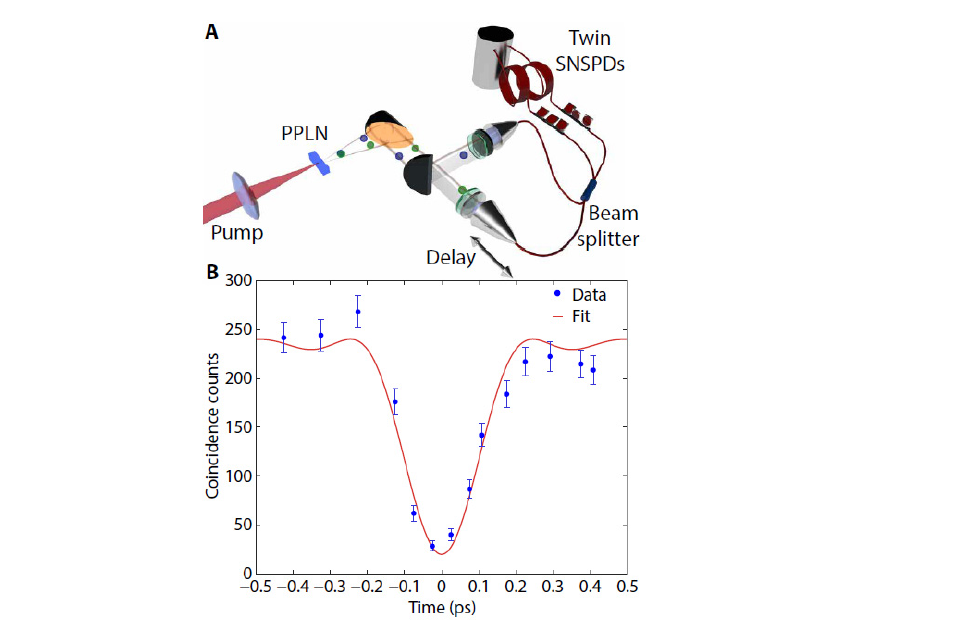
Figure 11. ( a ) Experimental setup for the demonstration of the two-photon interference. Downcon- verted photon pairs are created in a PPLN crystal; a tunable delay line is implemented to modify the temporal overlap of the photons at a beam splitter placed in front of twin SNSPDs used for the coincidence detection. ( b ) The two-fold coincidence counts (blue dots) with the corresponding fit (red line), showing the observed HOM dip. Reproduced with permission from [39], copyright 2020.